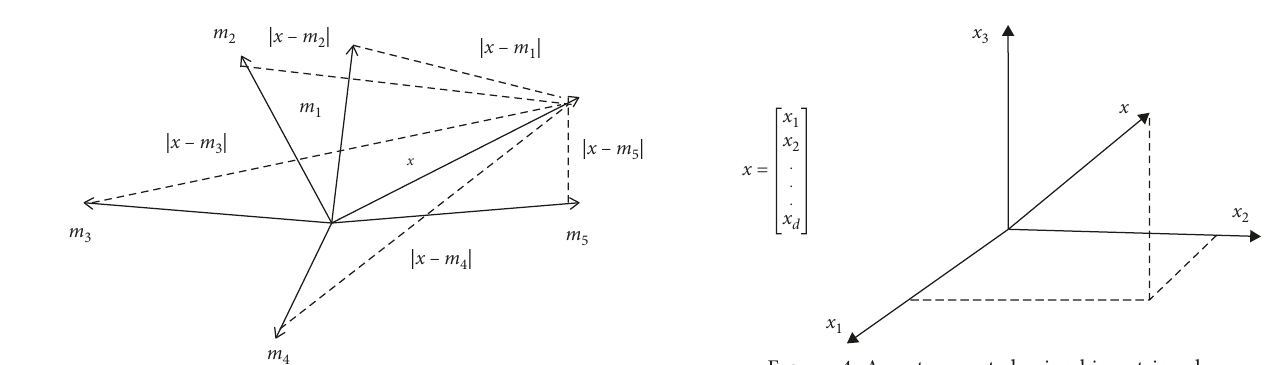
Figure 3: Sum of error calculation between vectors in EDM.